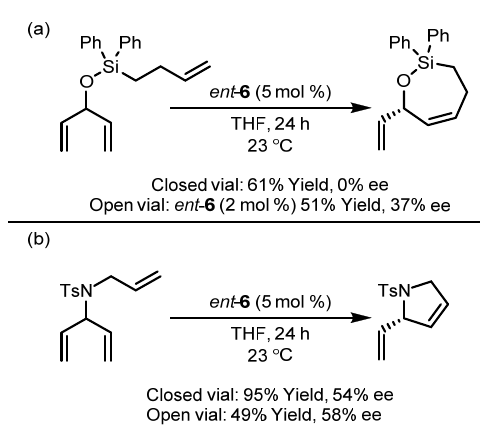
Figure 12. Effects of ethylene removal on asymmetric ring-closing metathesis (ARCM). ( a ) Effect of ethylene in ARCM to form seven-membered rings; ( b ) Effect of ethylene in ARCM to form five-membered rings.